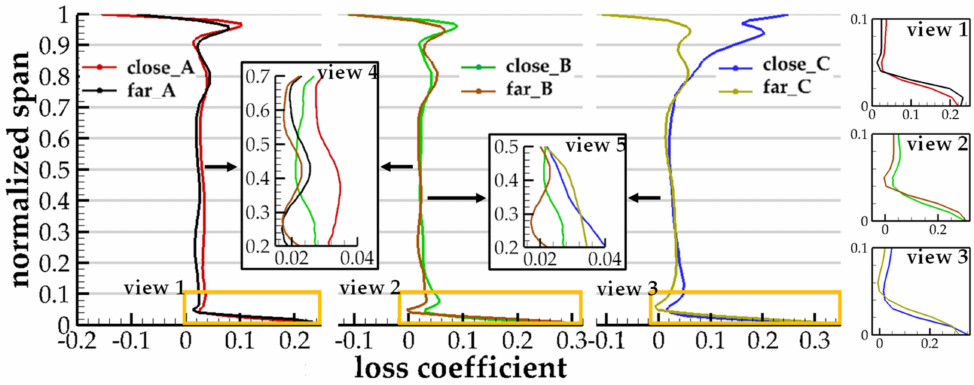
Figure 12. Radial distribution of the time-averaged stator loss